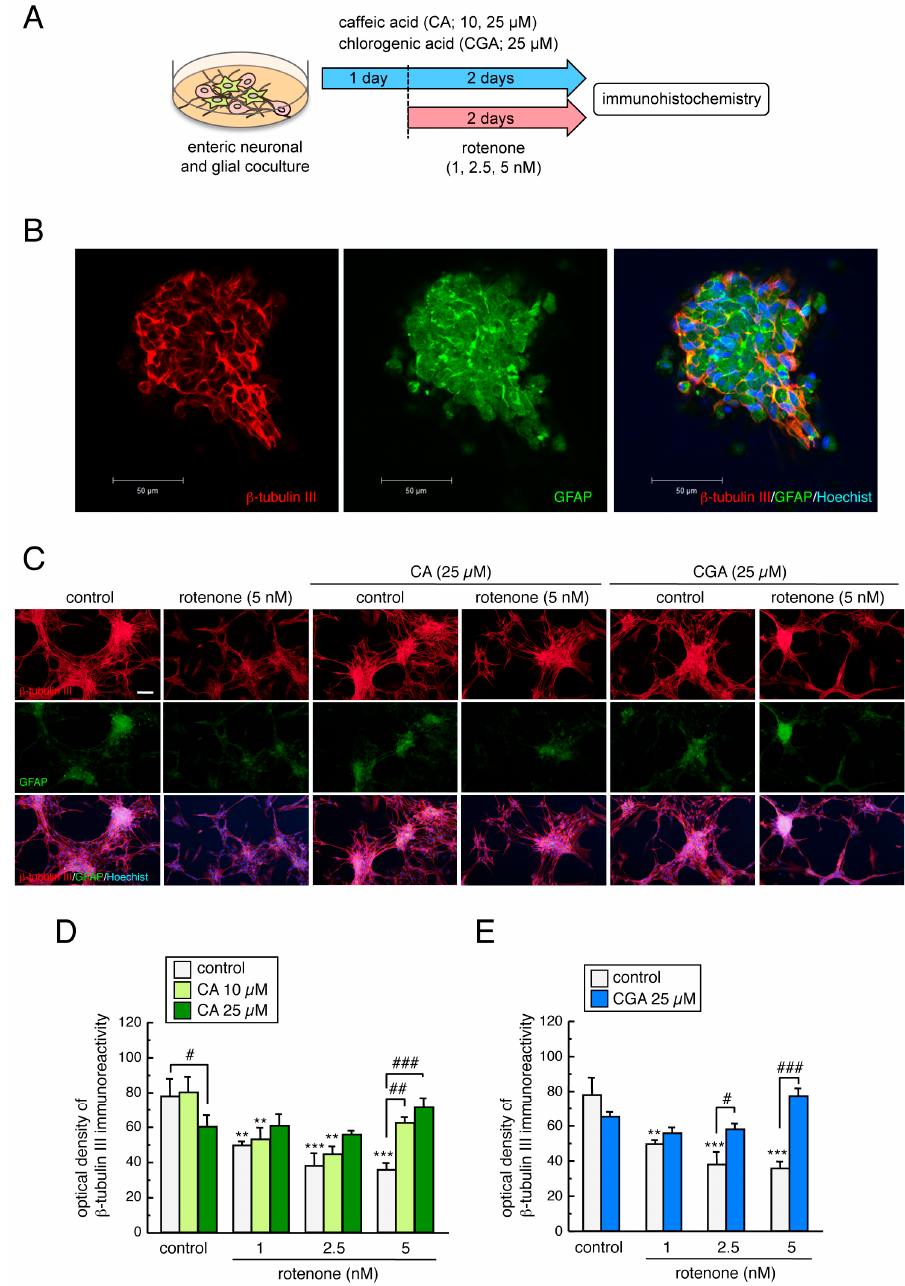
Figure 7. Neuroprotective effects of CA and CGA against rotenone-induced enteric neurotoxicity in primary cultured intestinal cells. ( A ) Schematic illustration of the experimental protocol. Enteric neuronal and glial co-cultures were pretreated with CA (10 or 25 µM) or CGA (25 µ) for 24 h and co-treated with rotenone (1–5 nM) for further 48 h. ( B ) Localization of β -tubulin III- and GFAP-positive signals. Red: β -tubulin III-positive enteric neuronal cells. Green: GFAP-positive enteric glial cells. Blue: nuclear staining with Hoechst 33342. Scale bar = 50 µm. ( C ) Representative photomicrographs of immunohistochemistry for β -tubulin III and GFAP in enteric cell cultures after treatment with rotenone (5 nM) and CA (25 µM) or CGA (25 µM). Red: β -tubulin III-positive enteric neuronal cells. Green: GFAP-positive enteric glial cells. Blue: nuclear staining with Hoechst 33342. Scale bar = 100 µm. ( D , E ) Quantitation of β -tubulin III-positive signals in enteric cell cultures after treatment with rotenone and CA ( D ) or CGA ( E ). Data are means ± SEM (n = 3–6). ** p < 0.01, *** p < 0.001 vs. each control group; # p < 0.05, ## p < 0.01, ### p < 0.001 between the two indicated